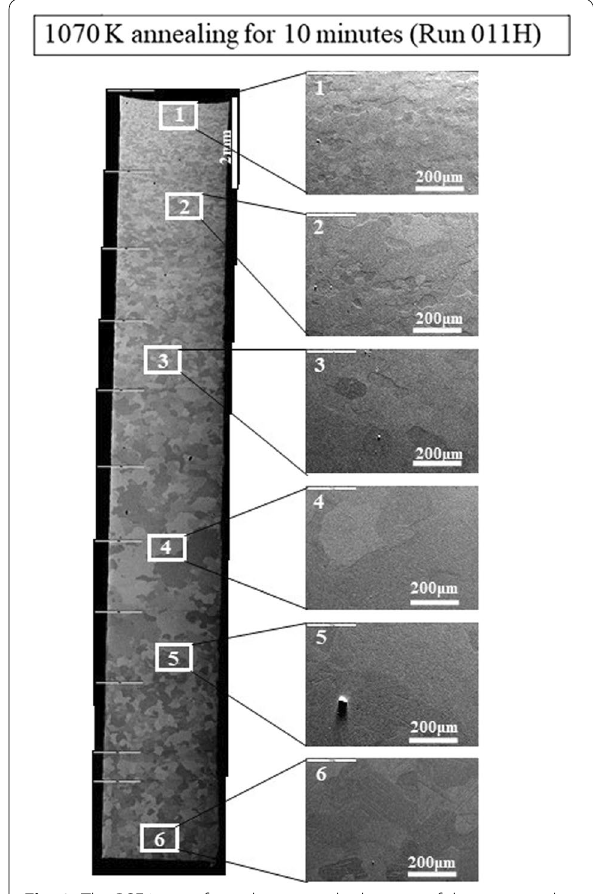
Fig. 9 The BSE image from the top to the bottom of the recovered sample annealed with the induction furnace at 1070 K for 10 min, and its locally magnified SEI images (Run